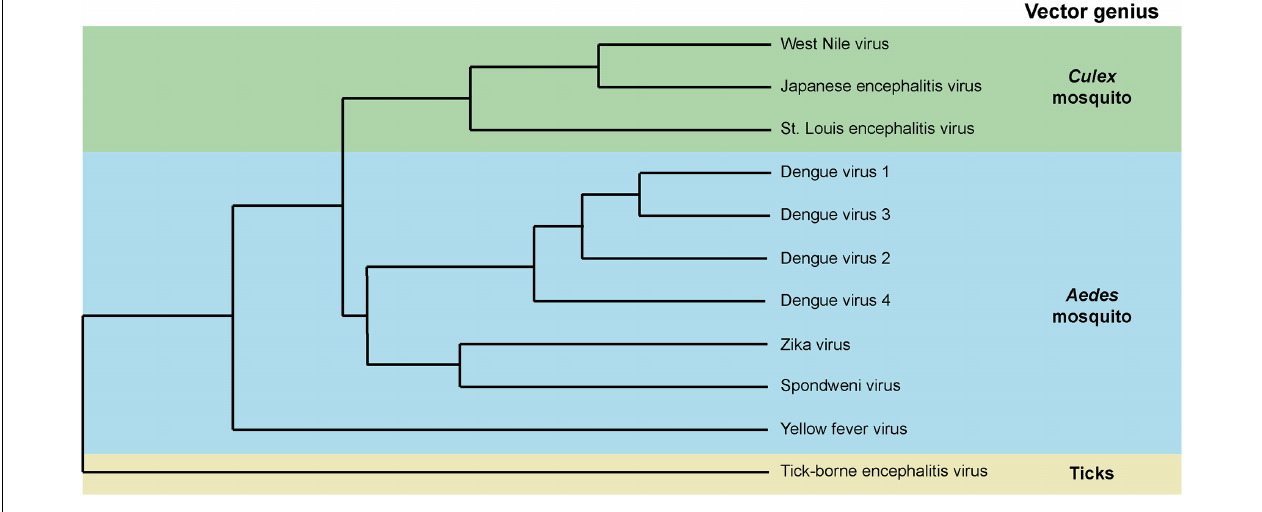
(C18:0) ( Figure 3A ). Palmitic or stearic acids undergo